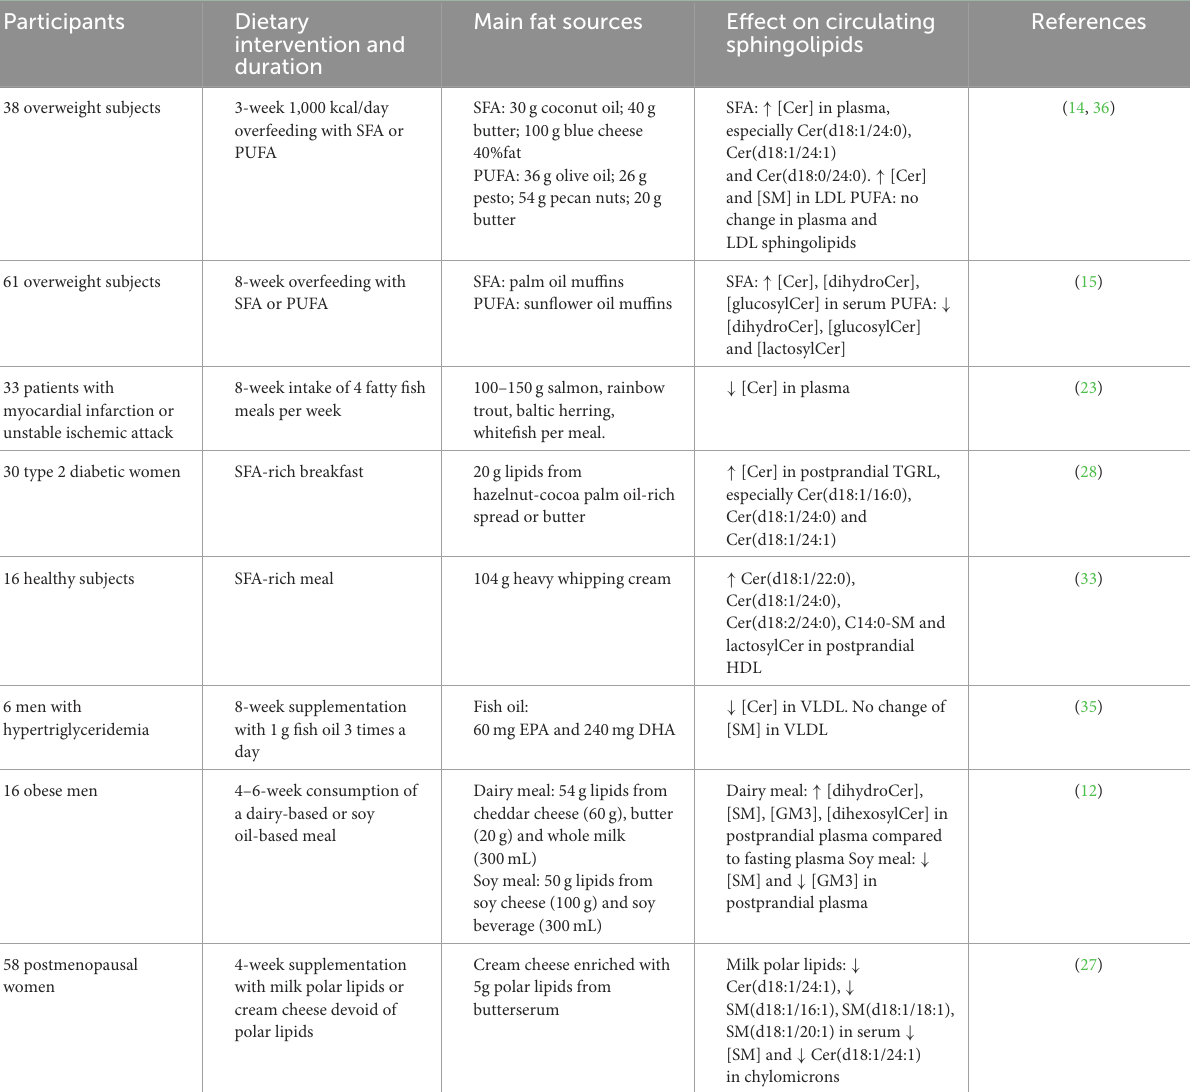
TABLE 1 Impact of dietary fatty acids and sphingomyelin on circulating sphingolipids in the randomized controlled trials mentioned in the text.